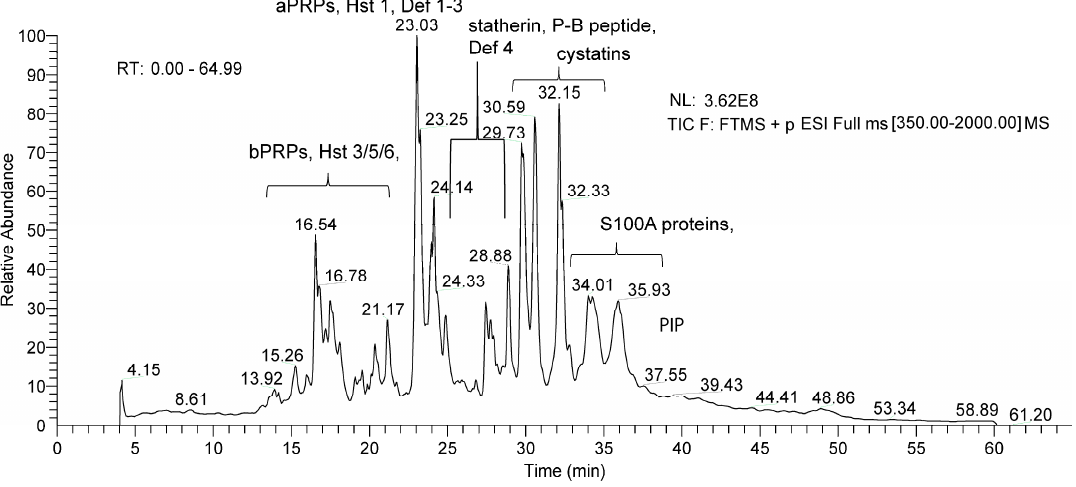
Figure 1. Typical total ion current (TIC) chromatographic profile of acidic-soluble fraction of adult saliva obtained by RP-HPLC-ESI-low-resolution MS analysis and indication of names and elution ranges of the protein families investigated.